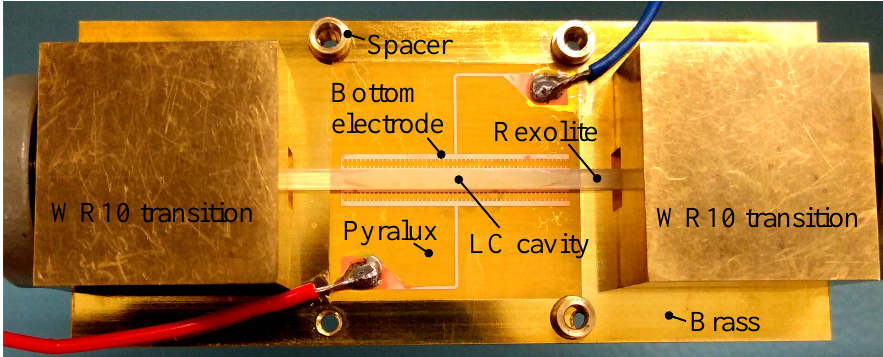
Figure 16. Photograph of the fabricated and partially assembled LC DIL phase shifter, presented in [23]. The upper electrode is placed over the LC cavity using spacers on the side.